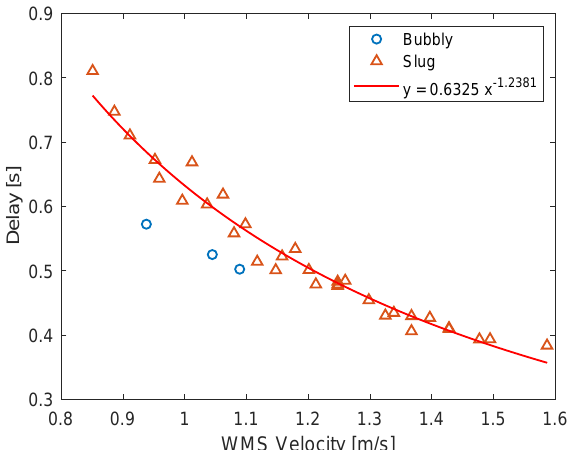
Figure 18. Delay that maximizes the cross-correlation between the camera gas fraction and the wire-mesh sensor gas fraction as a function of the velocity measured by the wire-mesh sensor. The symbols are used to illustrate the dependency of the relation on the flow pattern upstream of the swirl element.